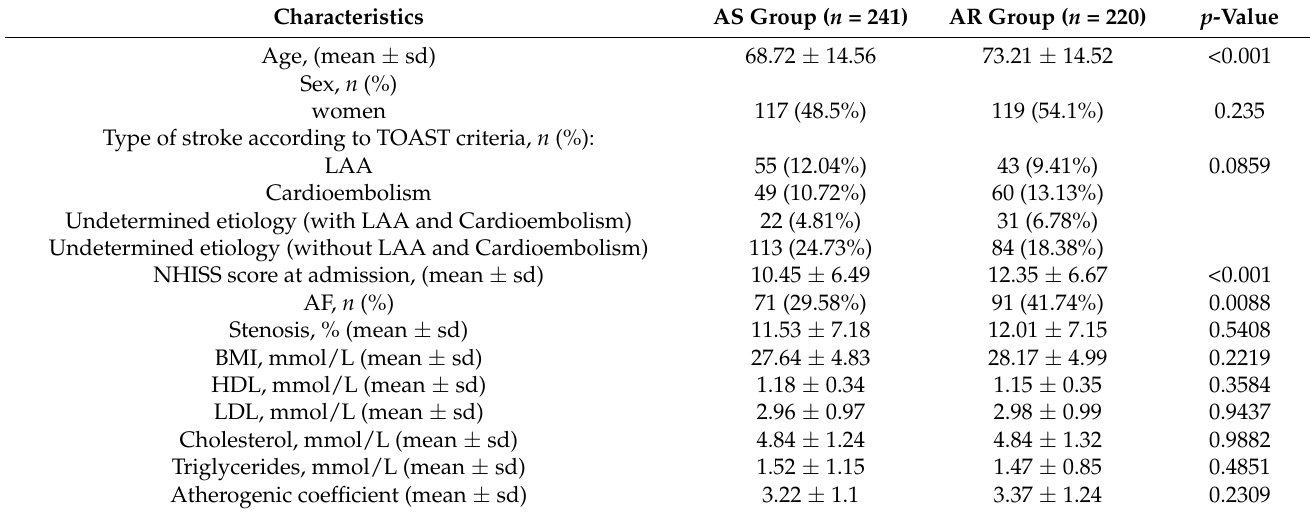
Table 2. The clinical characteristics and laboratory parameters in the AS and AR groups.